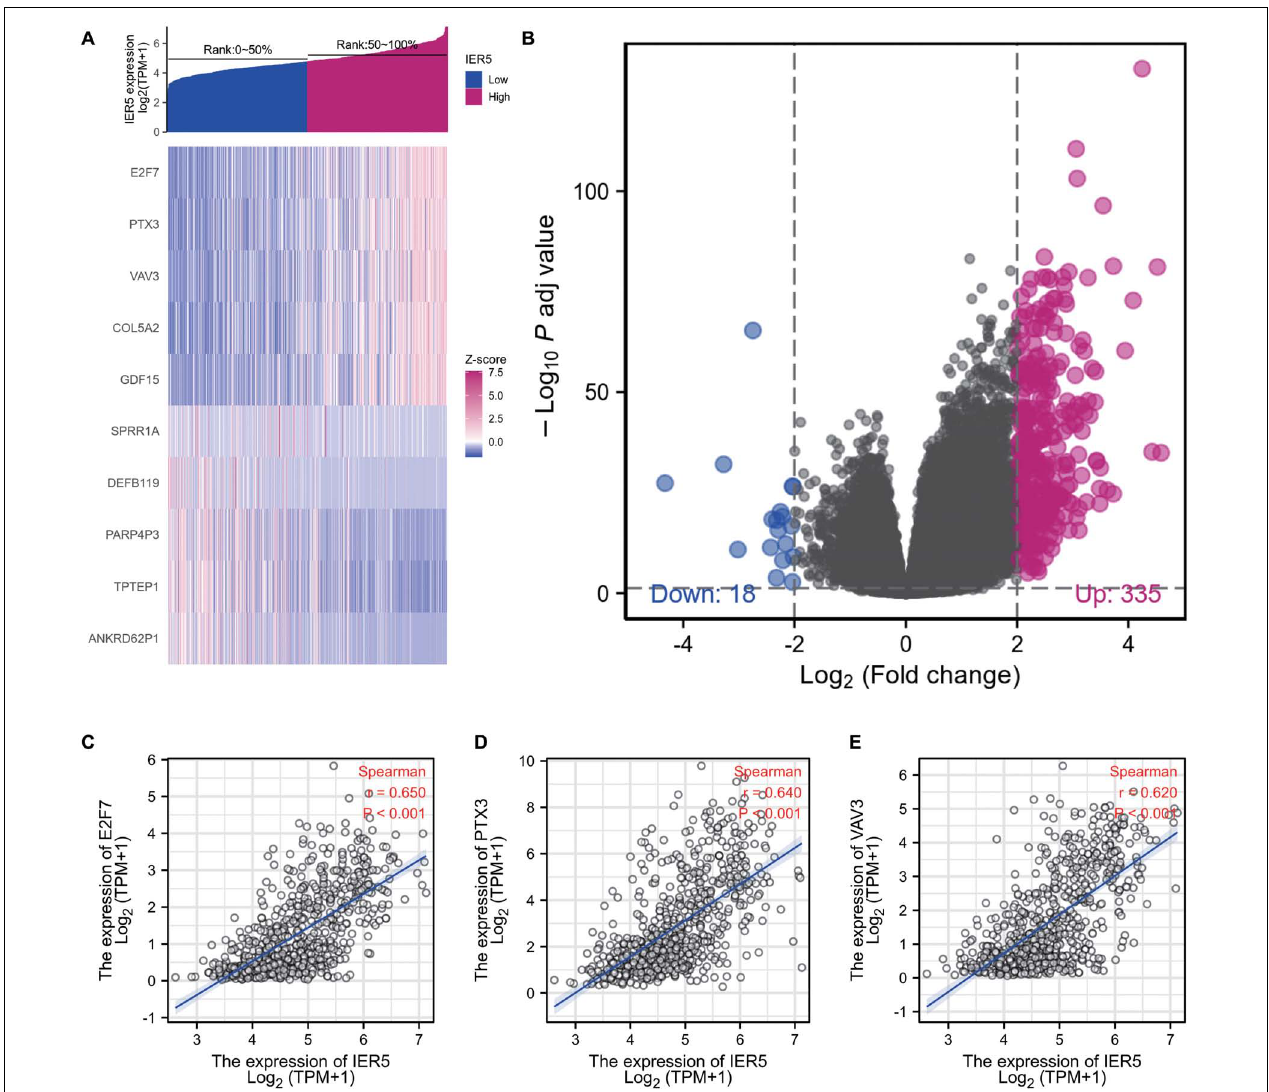
FIGURE 7 | DEGs between glioma patients with high- and low- IER5 expression. (A) Heat map of the 10 differentially expressed genes in the high- and low- IER5 expression groups. (B) Volcano plot of differentially expressed genes. (C–E) Correlation of IER5 expression with expression of E2F7 (C) , PTX3 (D) , and VAV3 (E) in the scatter